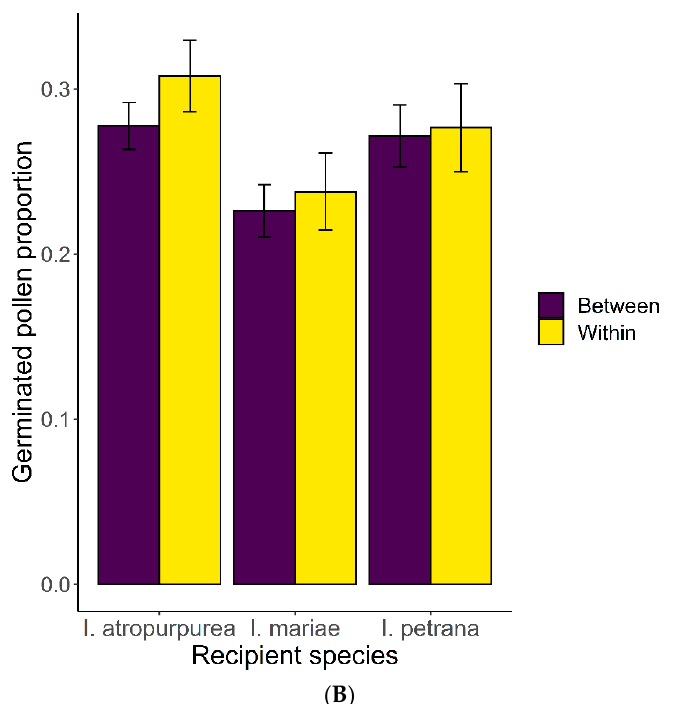
Figure 4. ( A ) Pollen grains and tubes of Iris atropurpurea on the stigma of a conspecific plant, stained with aniline blue. ( B ) The proportion of germinated pollen from within (yellow) and between (purple) the species origins on the stigmas of three recipient species. The differences between treatments were not significant ( p > 0.05) for all three recipient species.